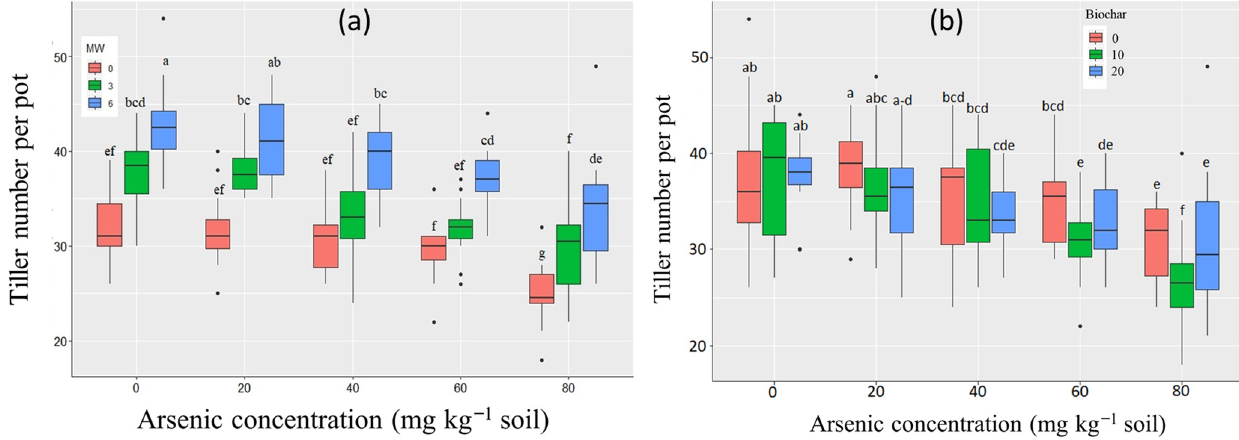
Figure 2. Effect of soil arsenic (As) concentration on tiller number in ( a ) microwave (MW and ( b )) biochar treated pot. The Least Significant Difference Test (LSD) was performed at 5% level of significance. In boxplot, values having different superscript letters indicate significant differences among the treatments.